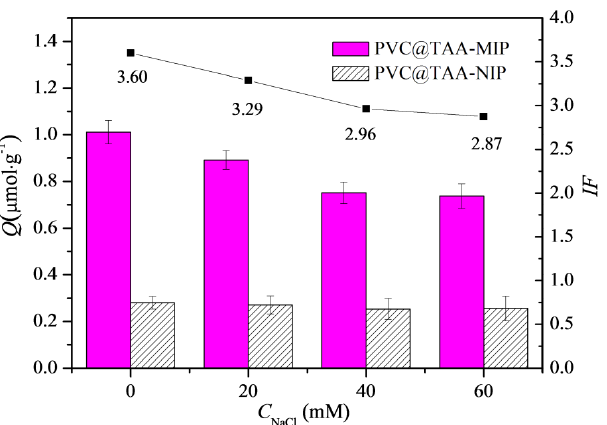
Figure 6. Influences of NaCl concentration on binding capacity and imprinting factor of PVC@TAA − MIP and PVC@TAA − NIP toward BSA.